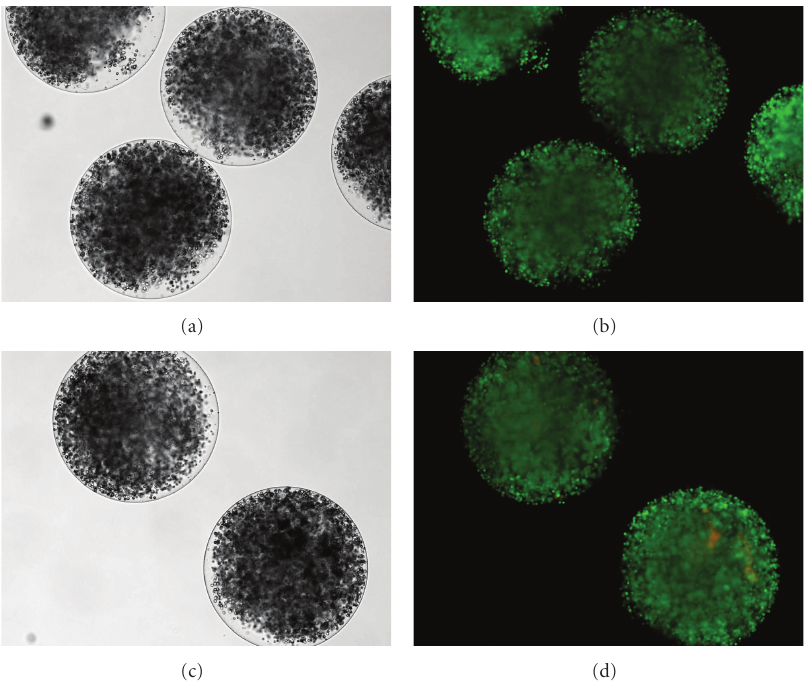
Figure 6: Optical (a,c) and fluorescence (b,d) photomicrographs of alginate microbeads containing IB3-1 cells after 1 (a,b) and 7 days (c,d) of cell culture. Fluorescence photomicrographs were taken after double staining with Calcein-AM and propidium bromide.